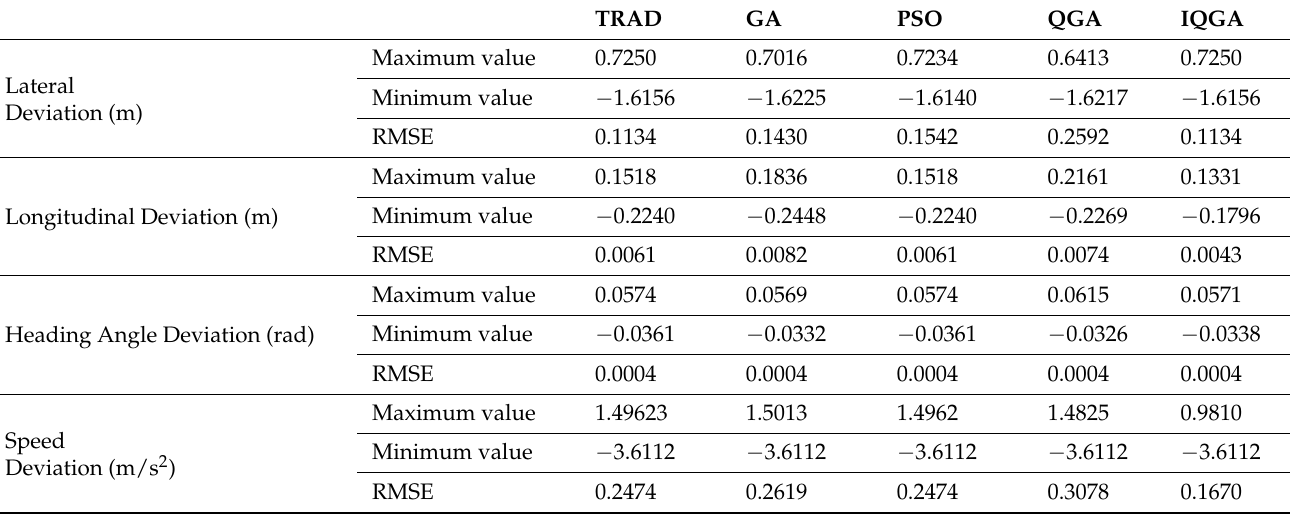
Table 4. Systematic deviations in tracking double-shifted trajectories. TRAD GA